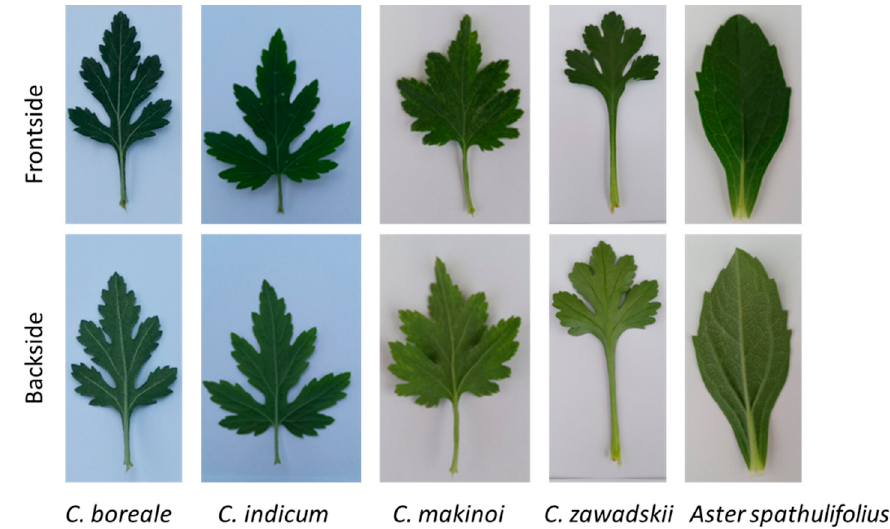
Figure 2. Sample images for five types of wild chrysanthemum.